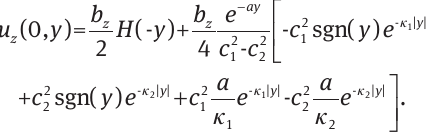
has an abrupt jump at the dislocation line y = 0, (Figure 1 A, B). For a fixed value of a , the larger the ratio c / c is, the smoother the solution becomes (Figure 1A). 2 1 = 0 represents the first gradient solution. The The case of c 2 gradient solution tends to the classic displacement when y → ± ∞ , as expected.